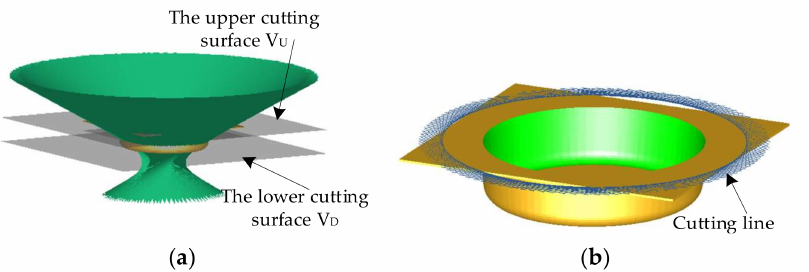
Figure 16. Intersection of cutting surfaces and rotated surface: ( a ) upper and lower cutting surfaces; ( b ) cutting lines.